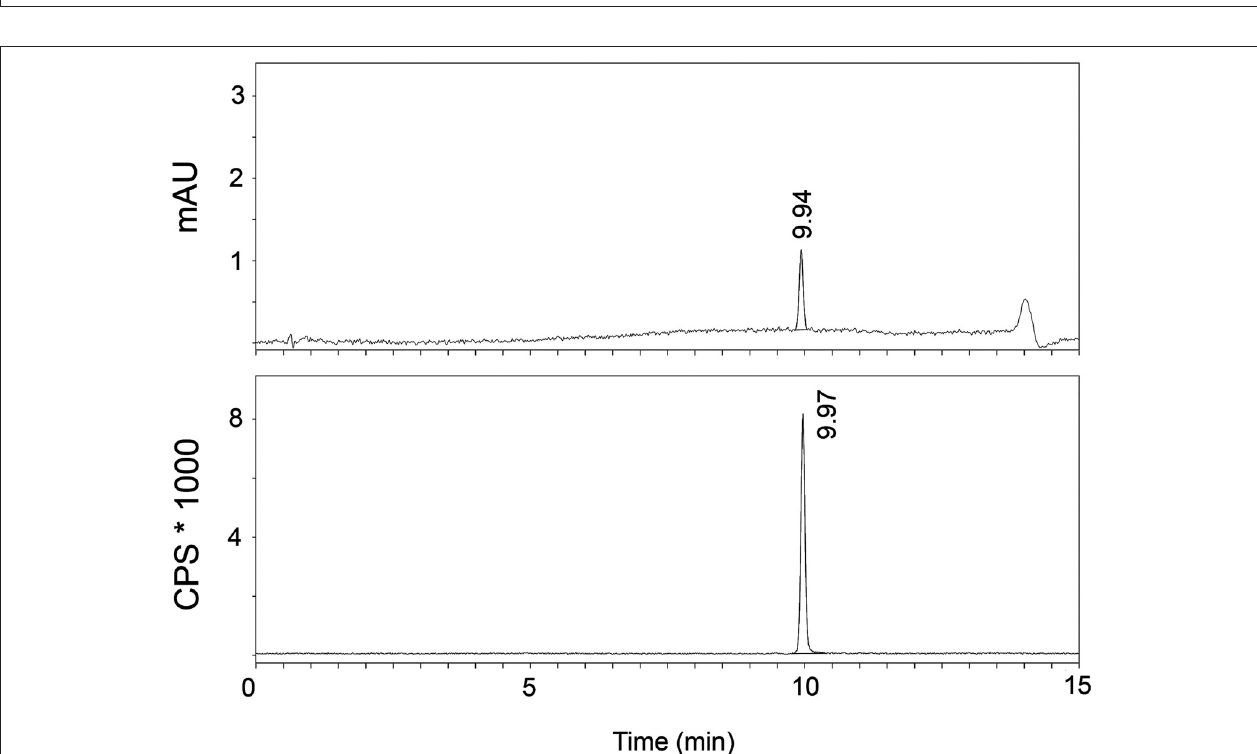
Frontiers in Neuroscience |